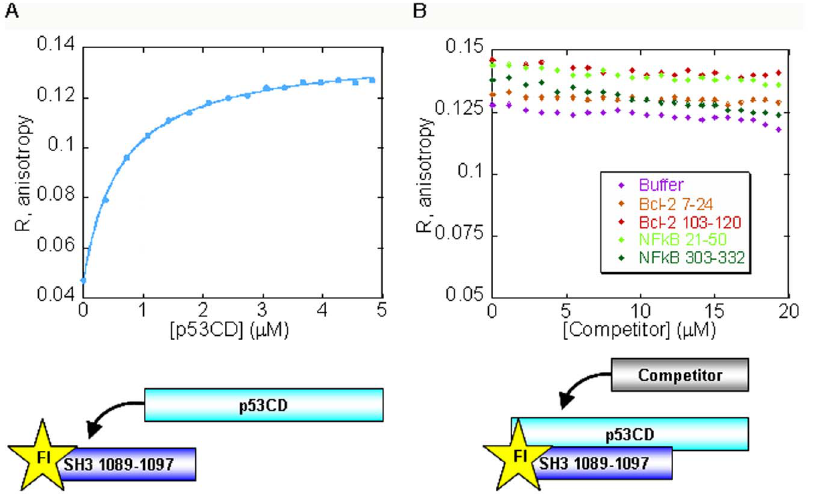
Figure4. Bcl-2 andNF k B peptides bind the ASPP2n-src loop 1089–1097 peptideina different site than p53CD. (A) p53CD bindsFl-ASPP2 1089–1097 ASPP2 SH3 derived peptide In fluorescence anisotropy experiments with K d =0.63 6 0.02 m M (B) Non-labeled Bcl-2 or NF k B peptides were titrated into the fully formed complex between Fl-ASPP2 1089–1097 and p53CD. None of the peptides displaced p53CD from the complex.